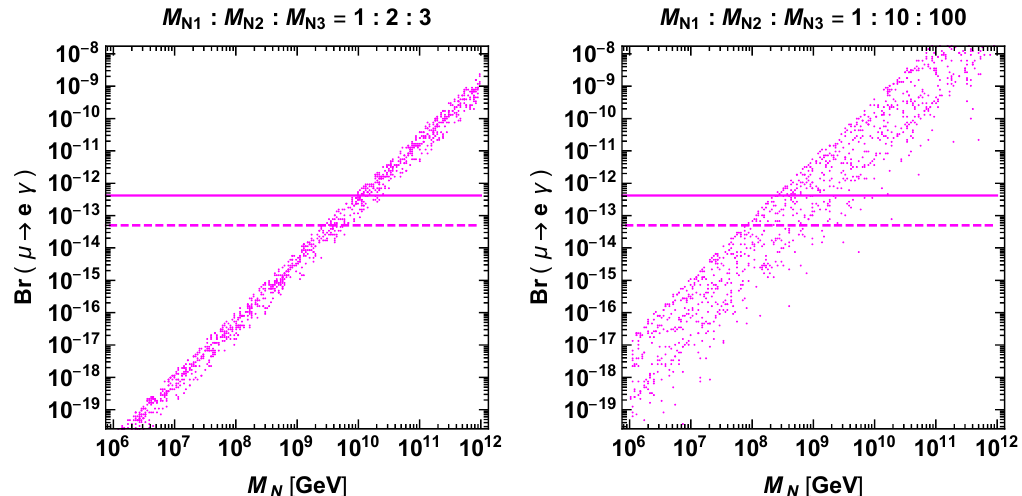
Figure 3 . BR( µ → eγ ) is shown for the model A . In the left (right) panel, M N 2 : 3 ( M N : M N : M N = 1 : 10 : 100 ) with M N = M N 1 2 3 and the other parameters are same as figure 2.